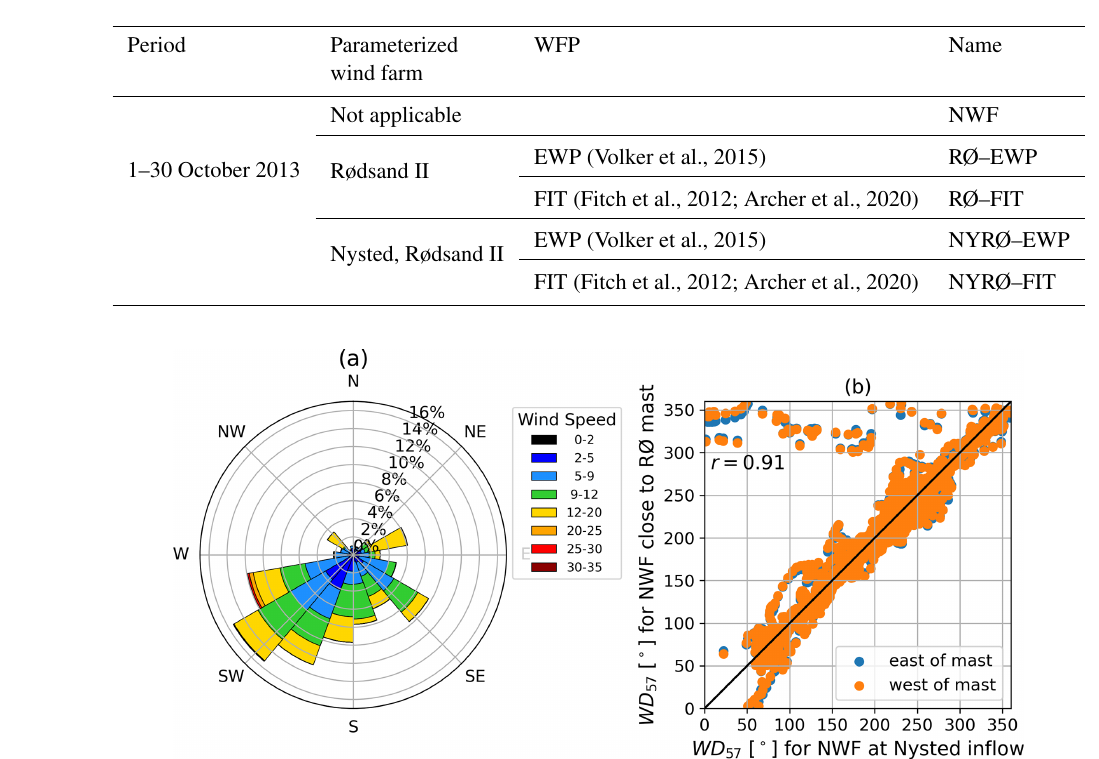
Figure 8. (a) Wake affected measured wind rose at the Rødsand II mast at 57m height for October 2013 and (b) for NWF inflow wind direction at Nysted inflow grid point versus wind direction close to the mast. For locations see Fig.